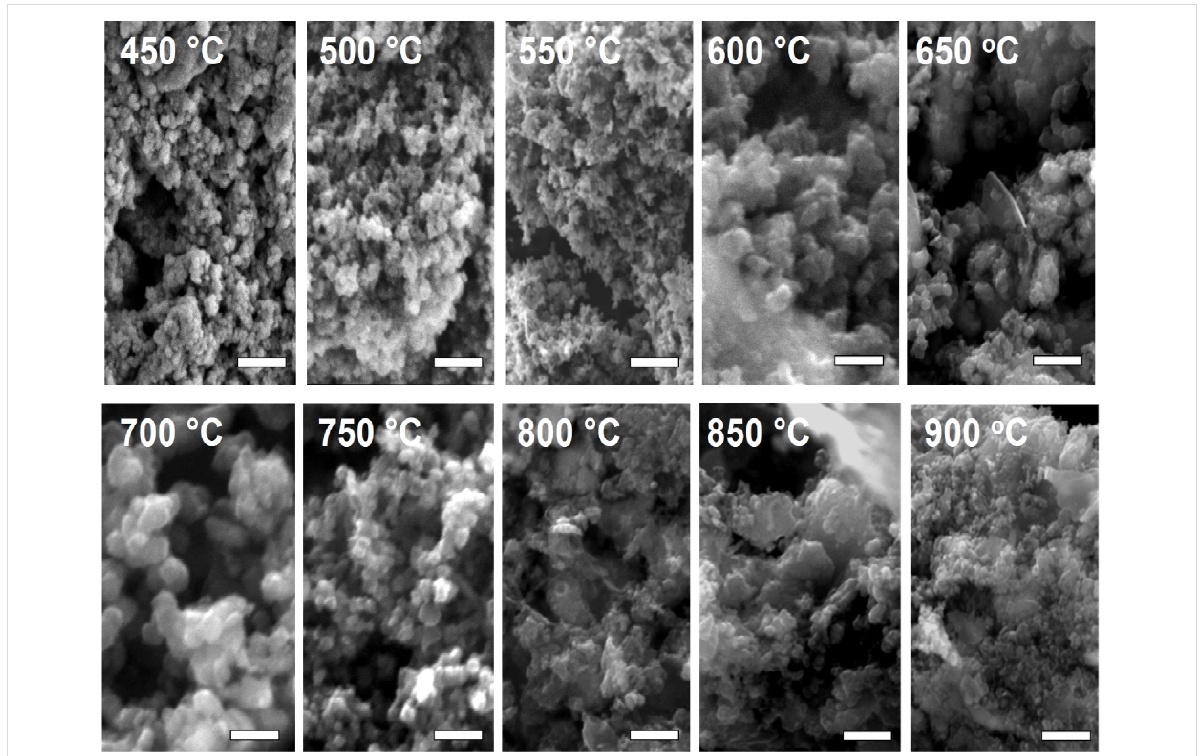
Figure 6: SEM images showing the growth pattern of 2Z-HYCA nanocomposite particles with increasing temperature after acid washing. All scale bars = 1 μ m.